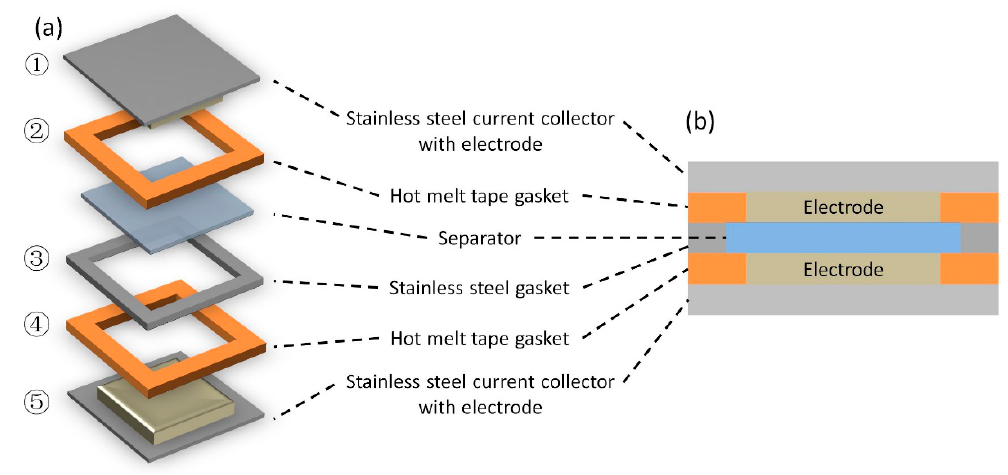
Figure 1. Schematic of the hermetic microscale packaging ( a ) component breakdown and ( b ) cross section view.